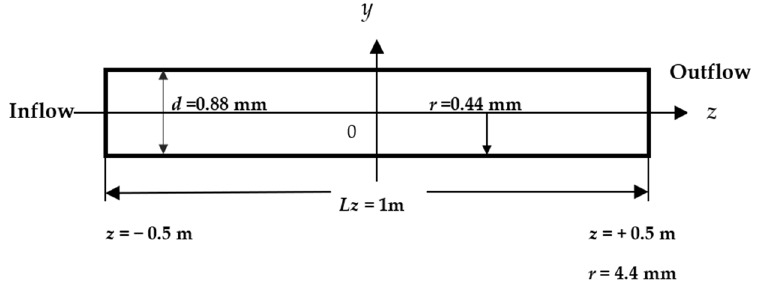
Figure 6. A schematic view of 2D computational domain of the y and z plane.